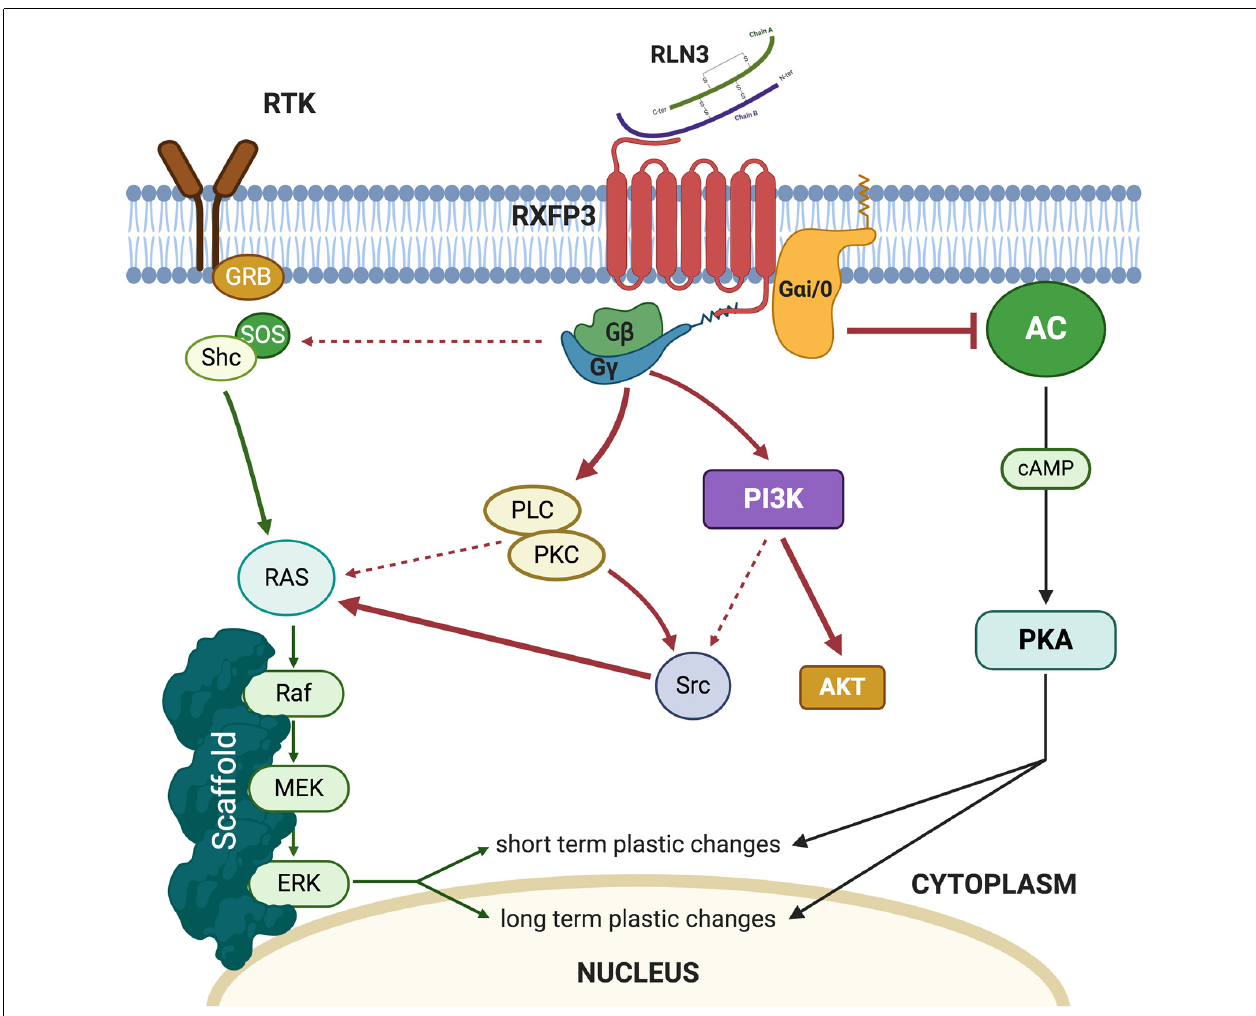
FIGURE 1 | Summary of the intracellular pathways triggered by relaxin-3 (RLN3) activation of